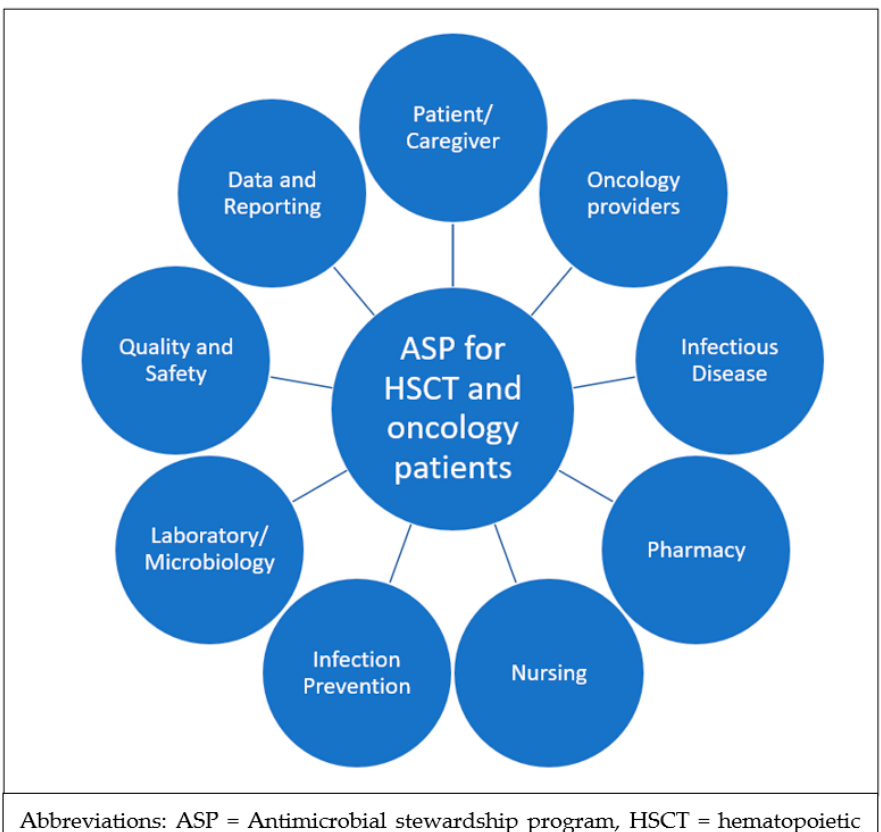
Figure 2. Multidisciplinary approach for ASP interventions in HSCT and oncology patients—Adapted with permission from Ref. [4]. Copyright 2022, Elsevier.